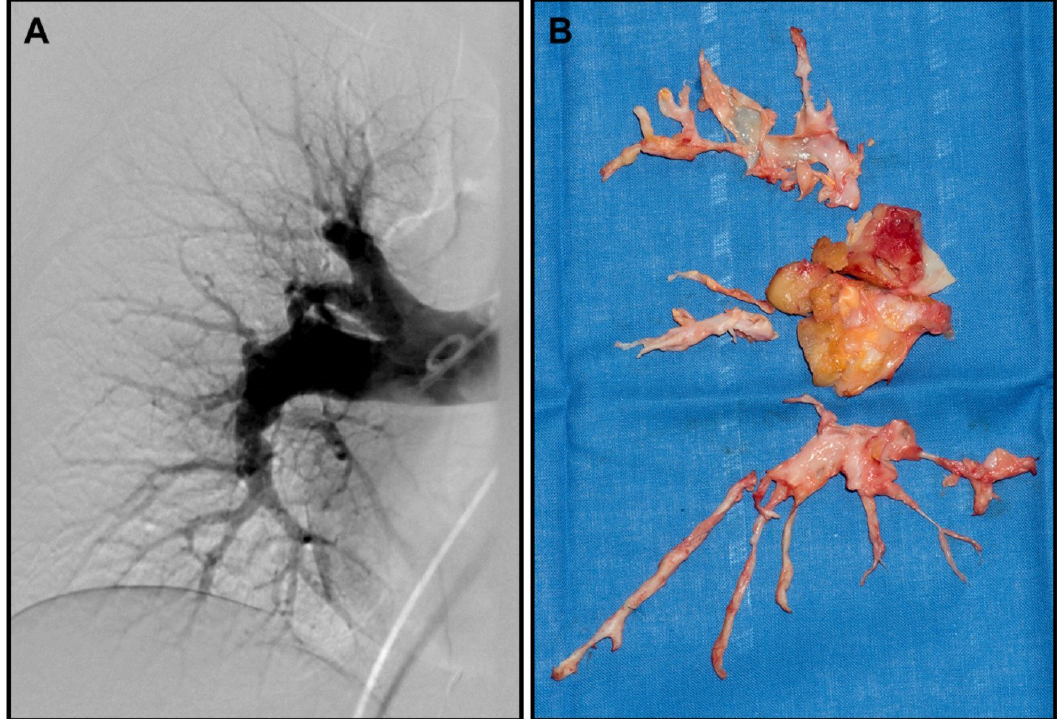
Figure 1. Representative CTEPH angiography and resection specimens: ( A ) Representative pulmonary digital subtraction angiography (Courtesy Prof. T. Frauenfelder) showing pouch-like ending of pulmonary artery segments, as well as stenosis and dilated pulmonary arteries. ( B ) Representative complete resection specimens (right lung) obtained during pulmonary endarterectomy.